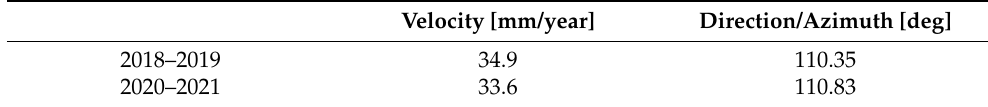
Table 4. Difference between velocities and directions.